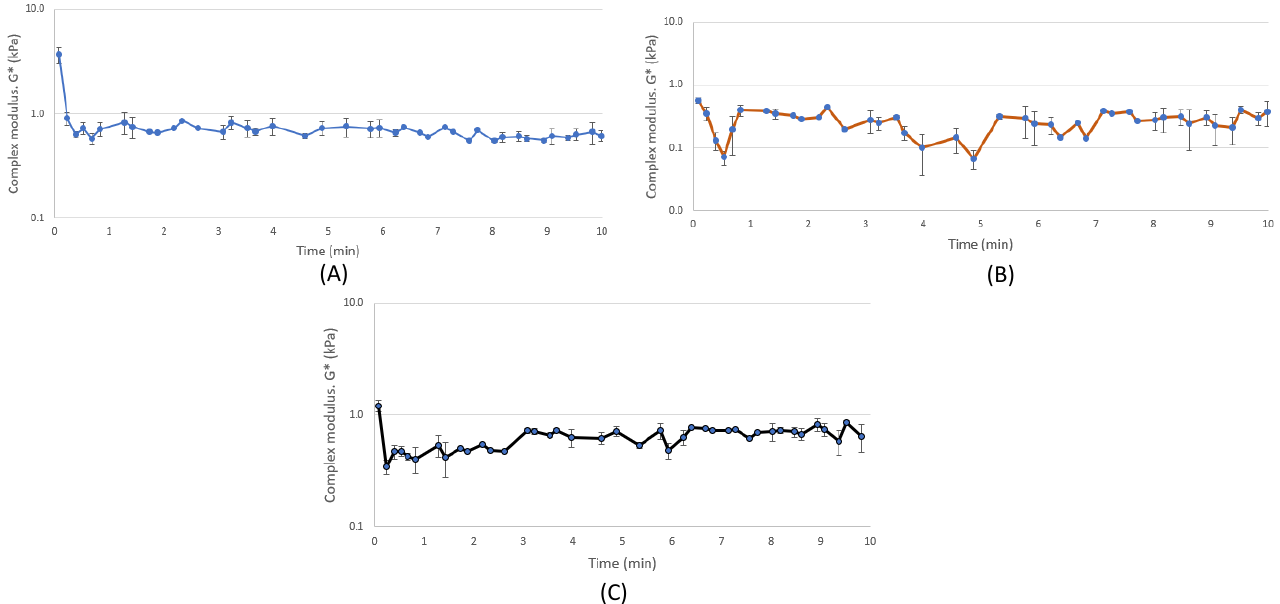
Figure 3. ( a ) Change in the complex modulus (G*) as a function of time of pea protein isolate.; ( b) Change in the complex modulus (G*) as a function of time of destarched oat protein concentrate.; ( c ) Change in the complex modulus (G*) as a function of time of destarched oat protein concentrate + pea protein isolate. The temperature, strain, and frequency were kept constant in all of the measurements (140 ° C, 80%, and 10 Hz, respectively). All measurements were carried out in triplicates except (b). The standard error bars in the graph are the standard errors of that specific point (n=3, and n=2 for b).